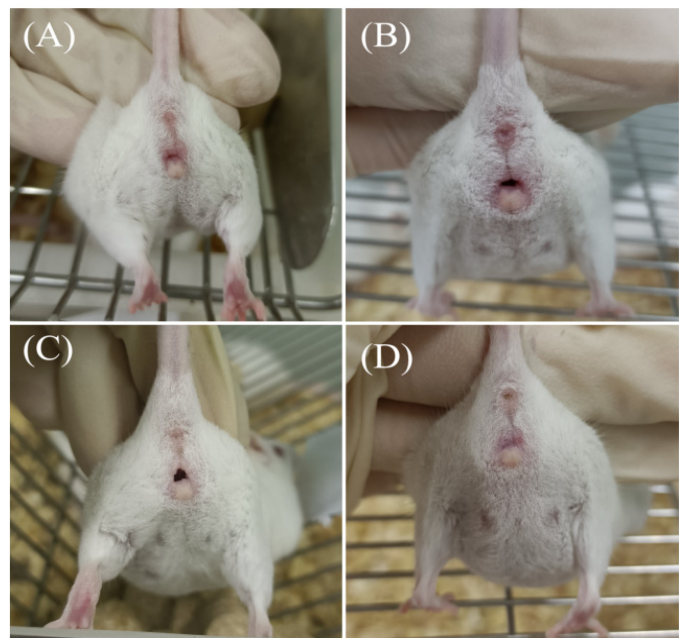
Figure 1. Vulvovaginal characteristics of mice. ( A ) Proestrus. Slightly swollen pink vulvar folds and slightly open vaginal orifice. ( B ) Estrus. Crimson and severely swollen vulvar folds, significantly enlarged vaginal orifice and more viscous secretions. ( C ) Metestrus. The vulvar swelling gradually subsided, and the color of the vaginal mucosa became white. ( D ) Diestrus. Vulvovaginal swelling subsided, vaginal openings closed and pale vaginal mucosa.